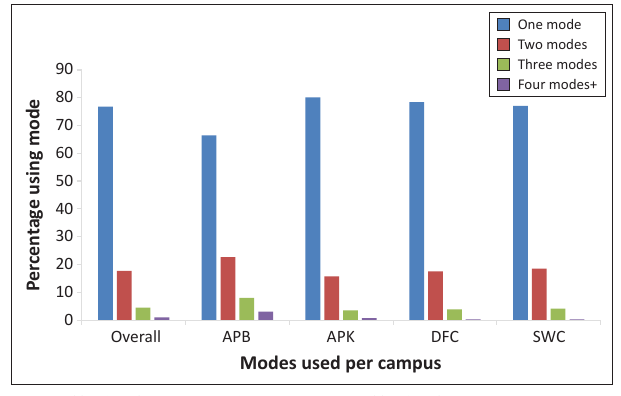
FIGURE 7: Number of modes used by students to access the campus of